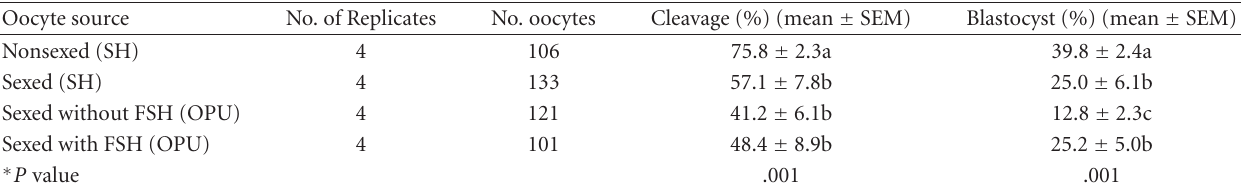
Table 1: Embryo production (%) using nonsexed and sexed sperm on slaughterhouse and OPU derived COCs. Oocyte source